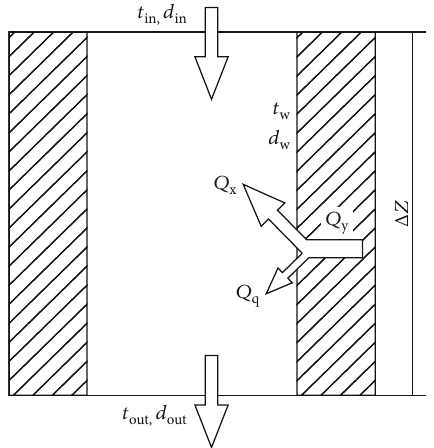
Figure 1: Heat and mass exchange between the surrounding rock and air fl ow.